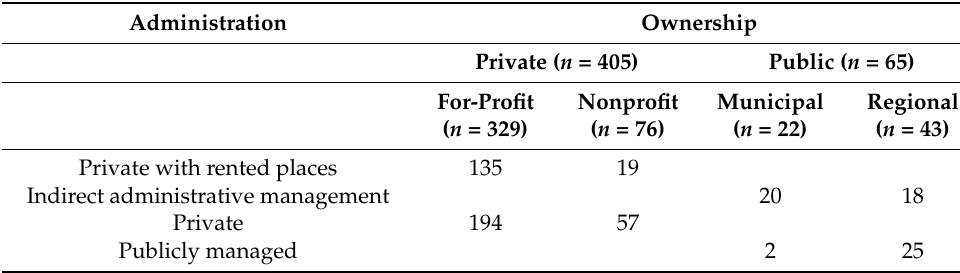
Table 1. LTCHs by ownership and administration type in the Community of Madrid,